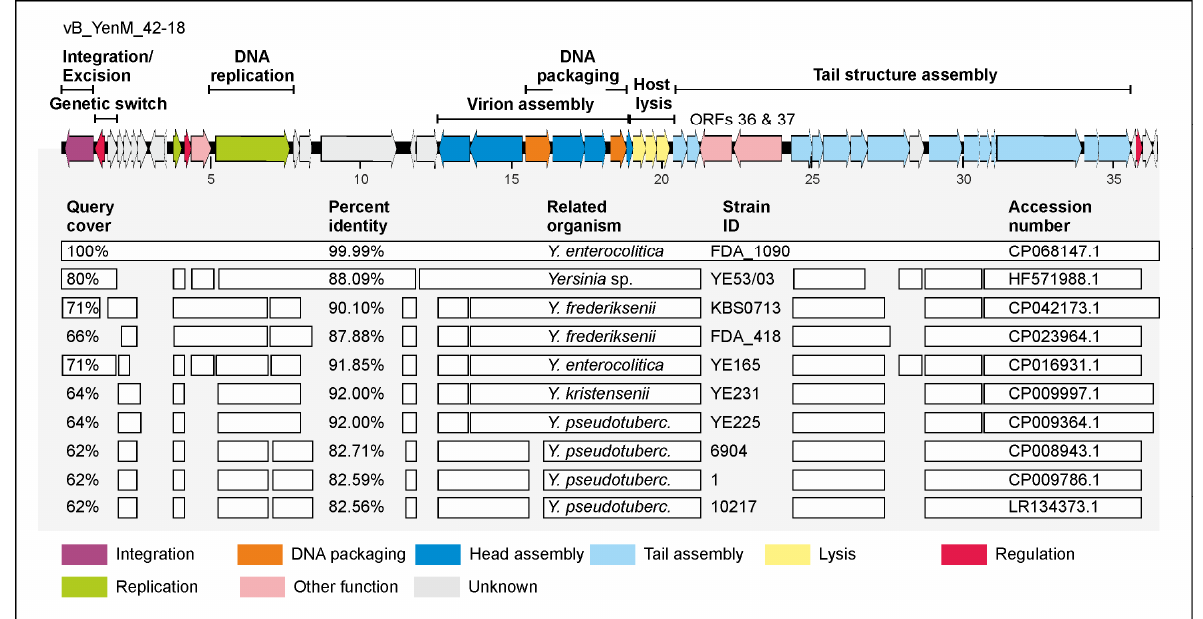
Figure 6. Gene map of phage vB_YenM_42.18 and its relationship to other prophages. Gene map of the phage and identity values with other prophage sequences. White bars represent regions of high nucleotide similarity (>75%).